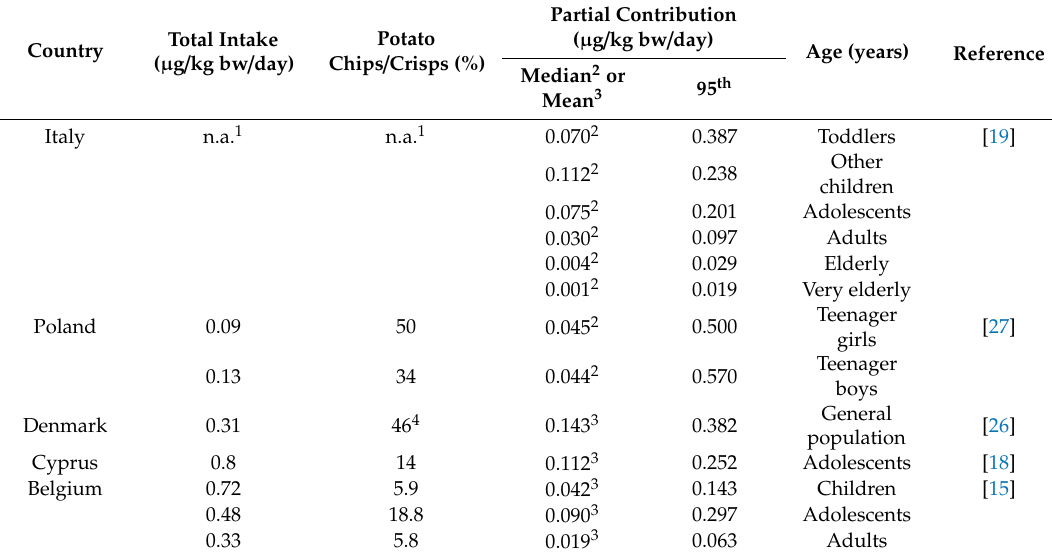
Table 3. Dietary acrylamide exposure and contribution of fried potatoes in di ff erent studies, countries, and population